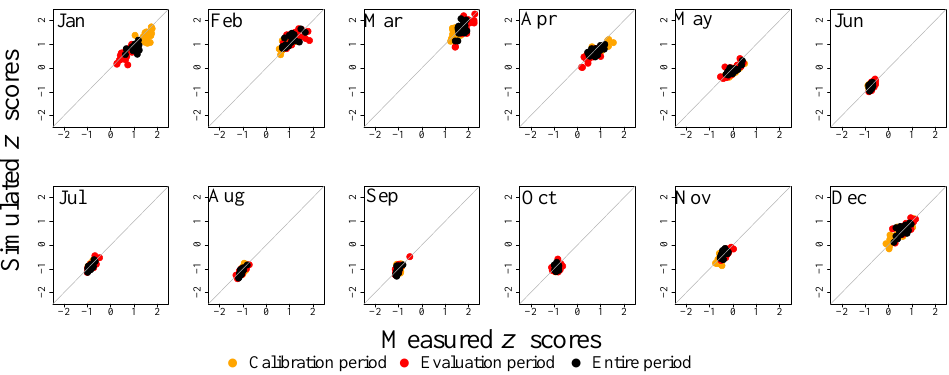
Figure 8. Measured vs. simulated mean monthly z scores for the Tennessee River calibration region (see Fig. 9b for location). Orange is calibration, red is evaluation, and black is all years.